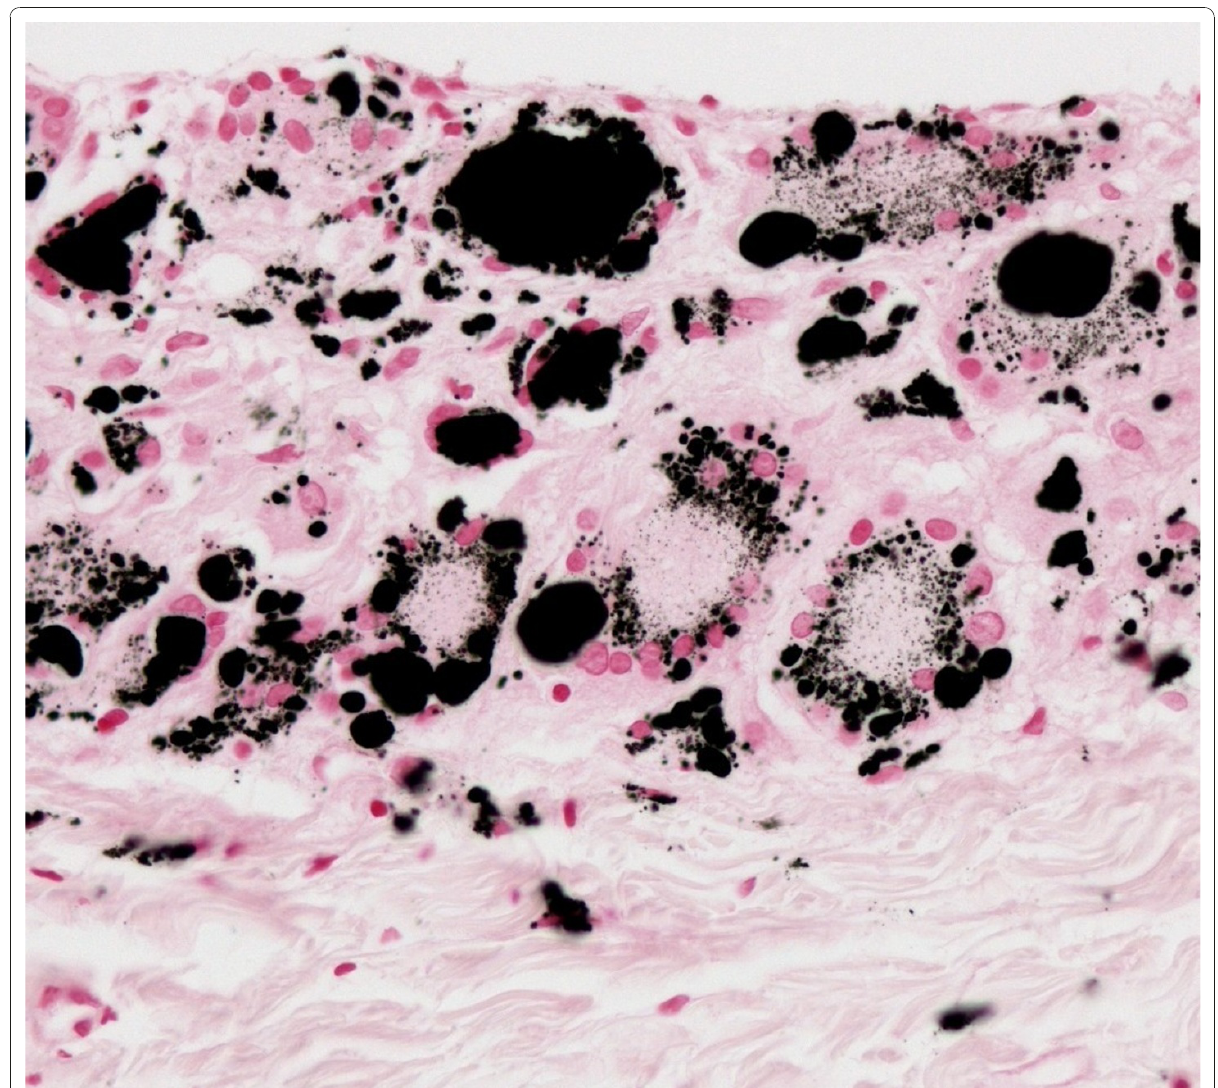
Figure 1 Light microscopy . Peritoneal biopsies show black material with a foreign body reaction in submesothelial tissue. Iron positive deposits are not seen (Prussian blue reaction,